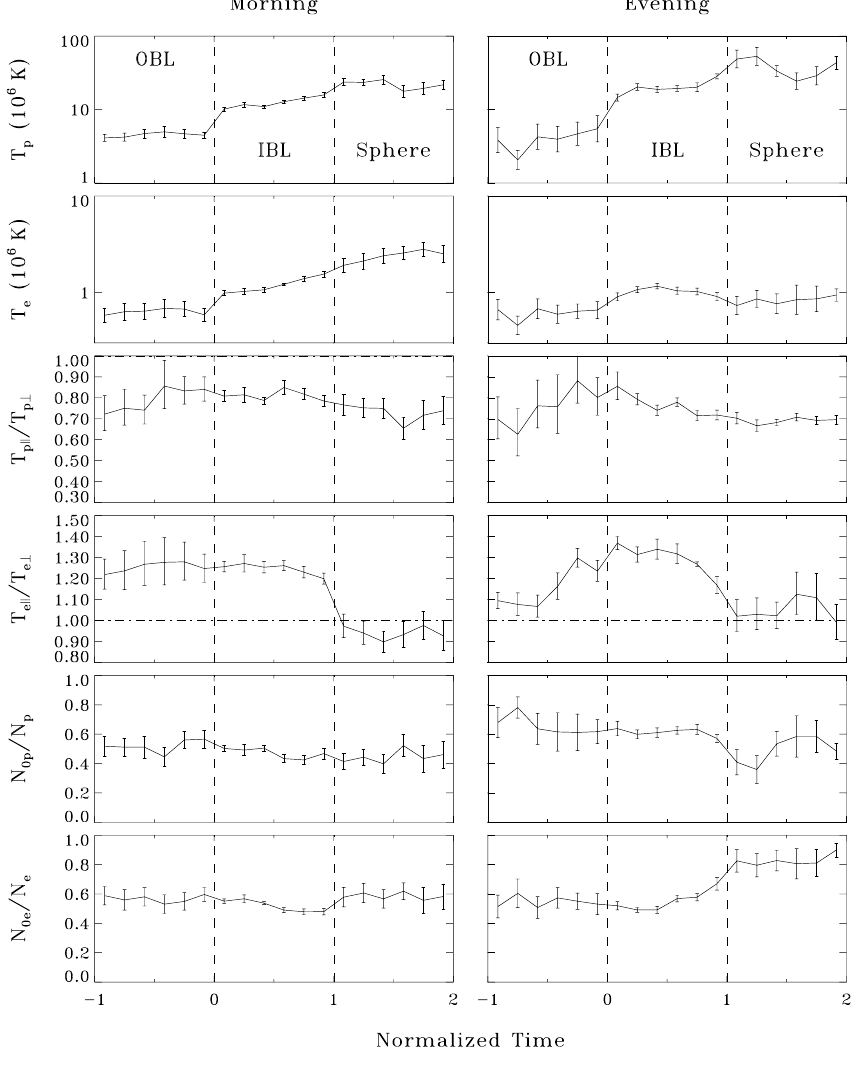
Fig. 8. Superposed epoch analysis of the proton temperature, T p , the electron temperature, T e , the proton temperature anisotropy, T p k /T p ⊥ , the electron tem- /T e ⊥ , the frac- perature anisotropy, T e k tion, N 0 p /N p , of protons below 400eV, and the fraction, N 0 e /N e , of electrons below 60eV across the inner bound- ary layer. The format is the same as in Fig.